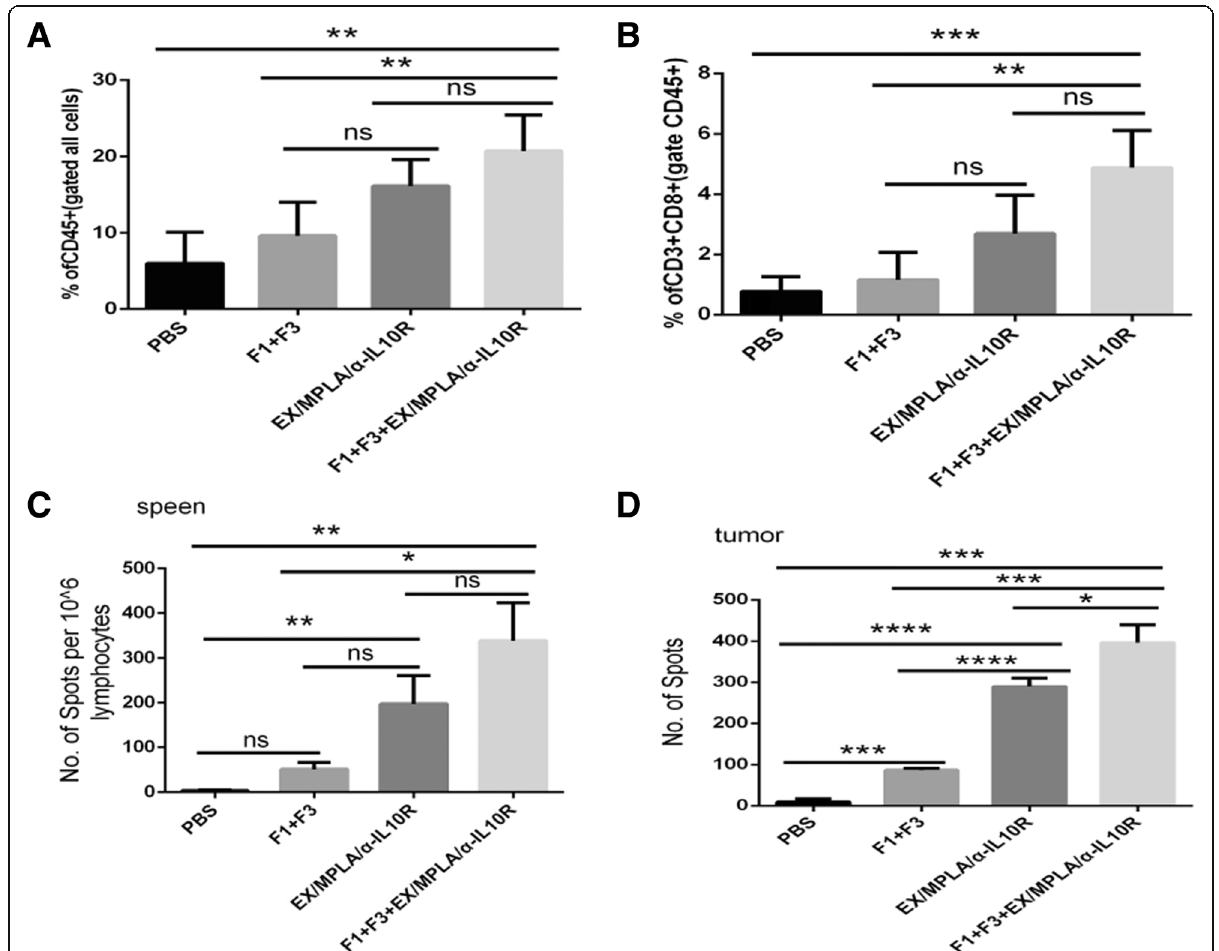
of TC-1 tumour cells. Four days after tumour inoculation, two groups were immunised twice 7 days apart with Ex/MPLA/anti-IL-10 receptor antibodies as described above. One day after the primary immunisation, mice were either injected for 7 consecutive days with 30 μ g of caerin 1.1 and caerin 1.9, or PBS. When the tumor diameter was 1 cm in the control group, the mice were sacrificed and the tumor tissues were dissociated, digested and analysed by flow cytometry for surface molecules expression of CD45.2, CD4, CD8a and NK1.1. ( a ) Percentage of CD45.2 cells; ( b ) Percentage of CD3 + CD8+ cells gated on CD45.2 cells; ( c ) Percentage of CD3 + CD4+ cells gated on CD45.2 cells; ( d ) Percentage of CD3-NK1.1+ of CD45.2 cells in tumor